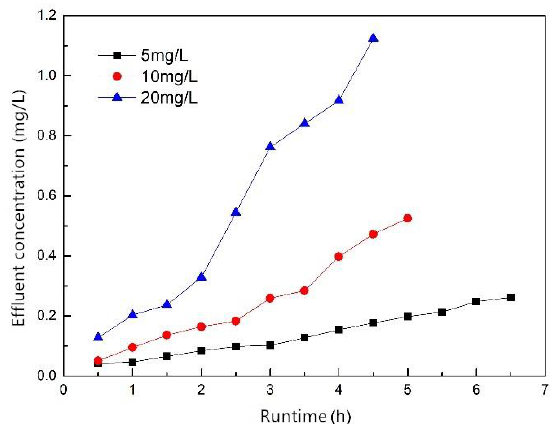
Figure 11. Breakthrough curves of different influent concentration.